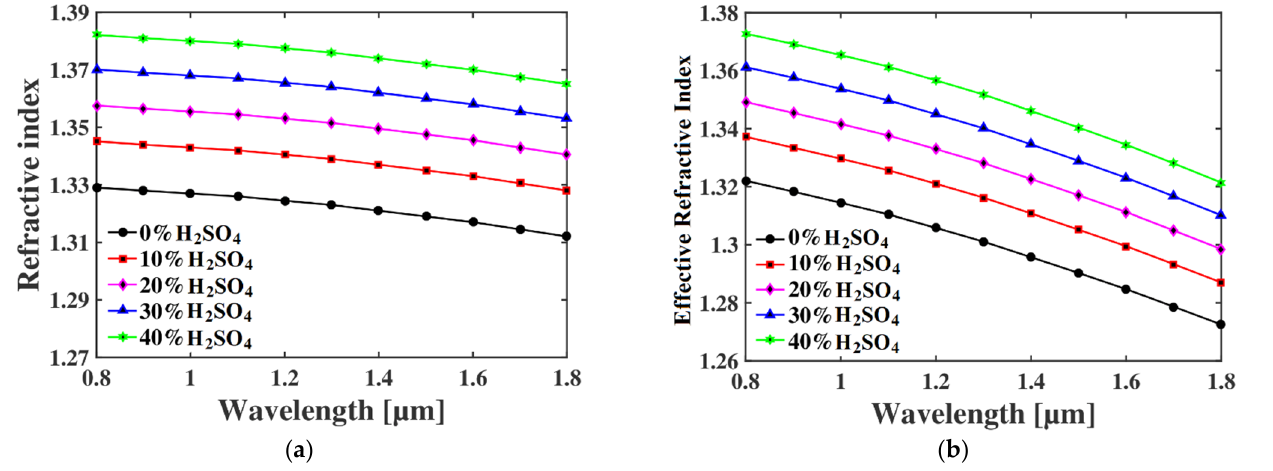
Figure 2. Graphical representation of the relationship between the ( a ) refractive index of different sulfuric acid of different concentrations with wavelength and ( b ) effective refractive index of the guided light with wavelength through the optical sensor.